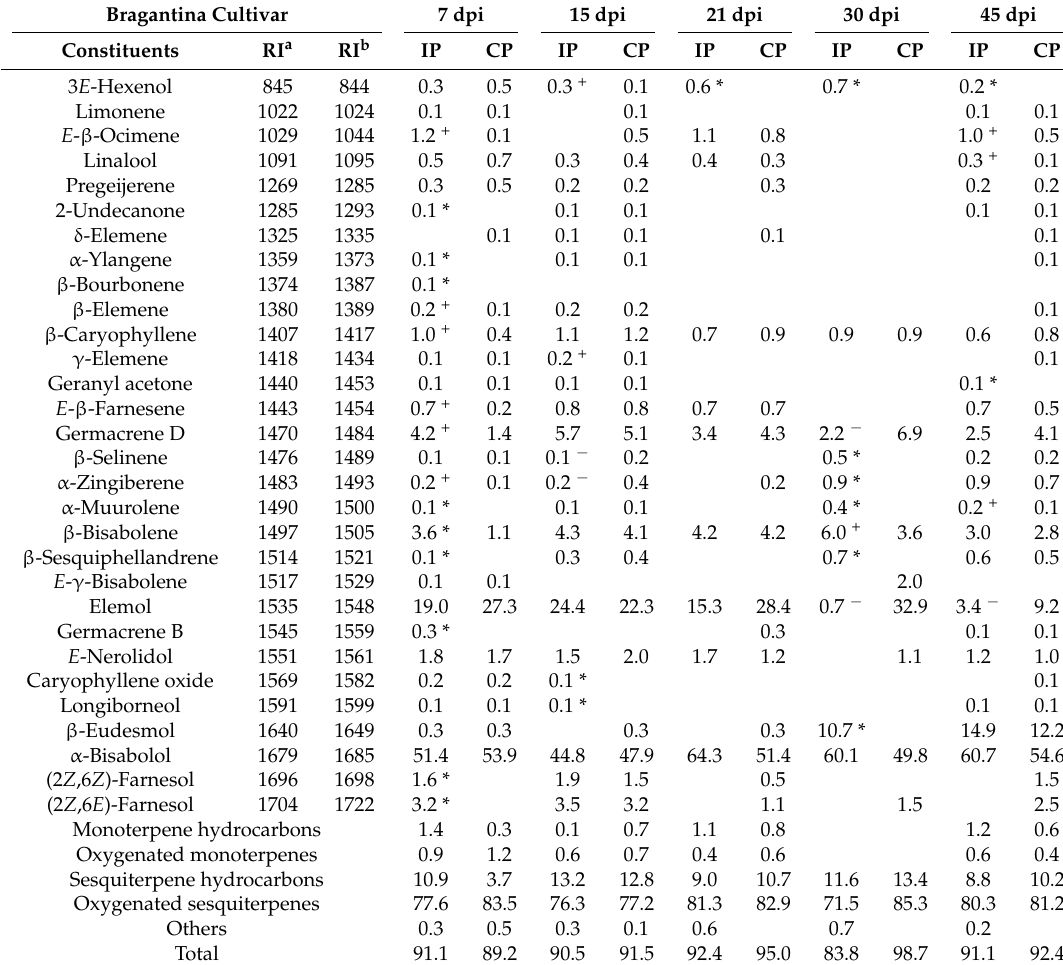
Table 1. Volatile compounds (%) of the leaves of Bragantina cultivar: inoculated plants (IP) and control plants